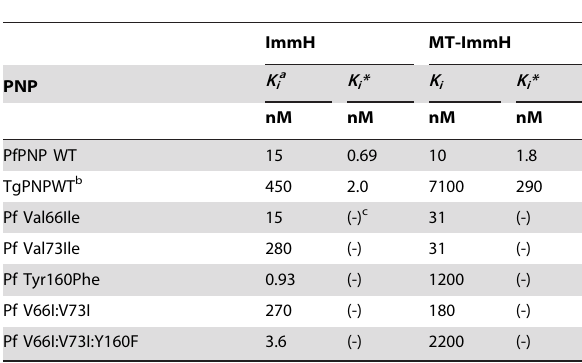
Table 3. Inhibition constants for